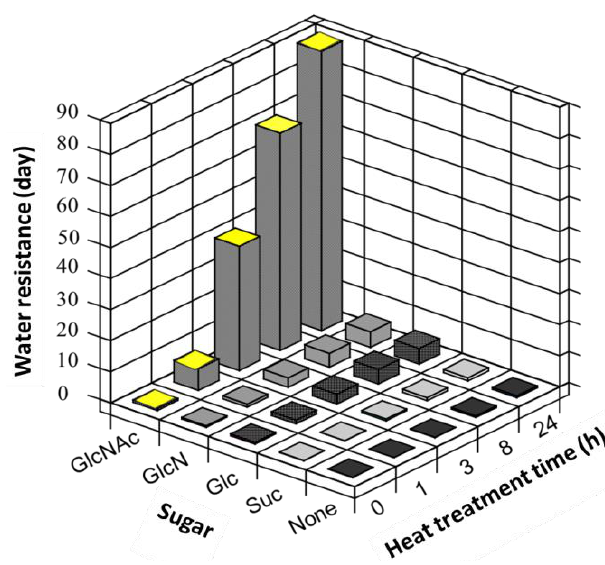
Figure 10. Effect of heat treatment time on the water resistances of gelatin fibers crosslinked with different sugars.